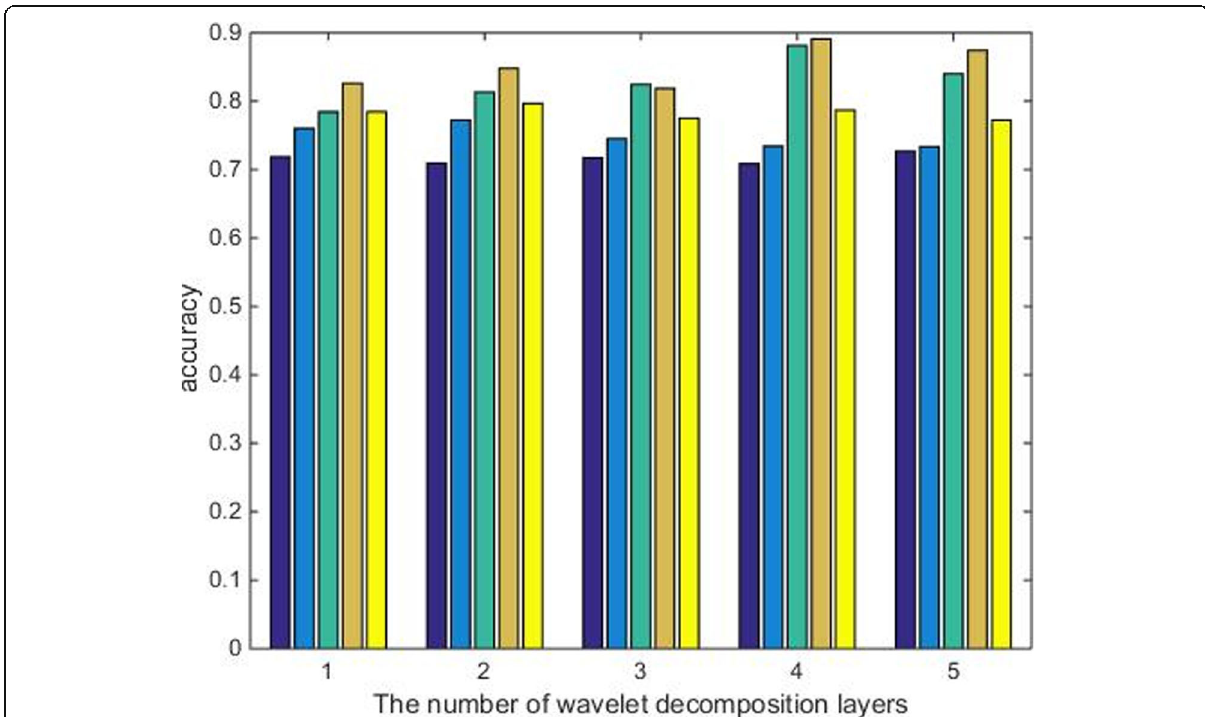
Fig. 6 The influence of wavelet layers and different wavelet bases on accuracy (the 1, 2, 3, 4, and 5 in the x-coordinate represents the number of wavelet decomposition layers. The five columns correspond to Daub(2), Daub4), Daub(6), cubic b-spline wavelet, and orthogonal basis wavelets, respectively. Ordinates are the accuracy of image recognition)